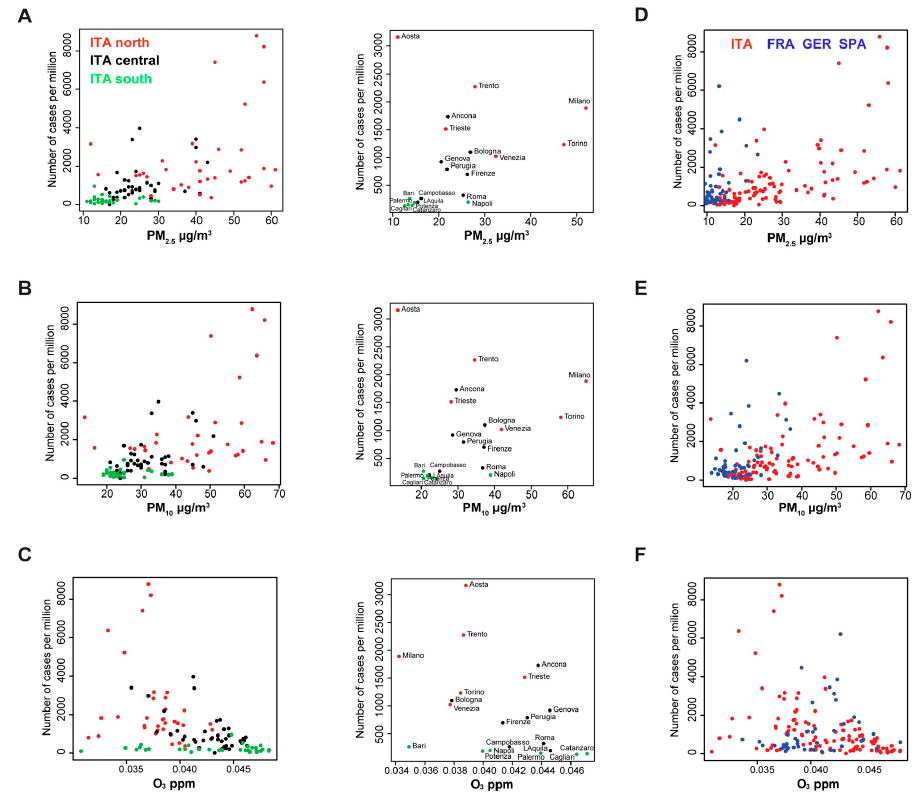
Figure 1. Correlation between SARS-CoV-2 cases in 107 Italian provinces using PM 2.5 , PM 10 and O 3 . The scatterplots display the values of three atmospheric factors and the number of cases per million in 107 provinces (left panels) and selected provinces with regional capitals (middle panels). ( A ) PM 2.5 ; ( B ) PM 10 ; ( C ) O 3 . Different colors represent Italian provinces at different latitudes. Red dots: provinces with a latitude higher than 44.84N; black dots: provinces with a latitude comprised between 41.50N and 44.86N; green dots: provinces with a latitude lower than 41.50N. ( D – F ) The scatterplots display the concentration of PM 2.5 , PM 10 , and O 3 . Red dots represent Italian provinces, blue dots FGS regions.